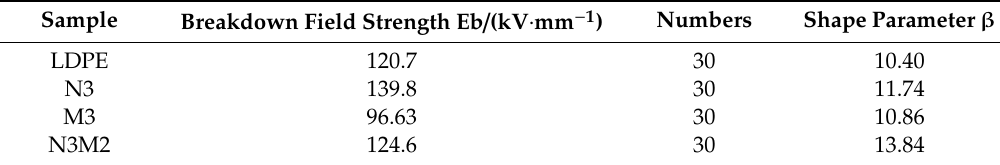
Table 3. AC breakdown characteristics of different samples.